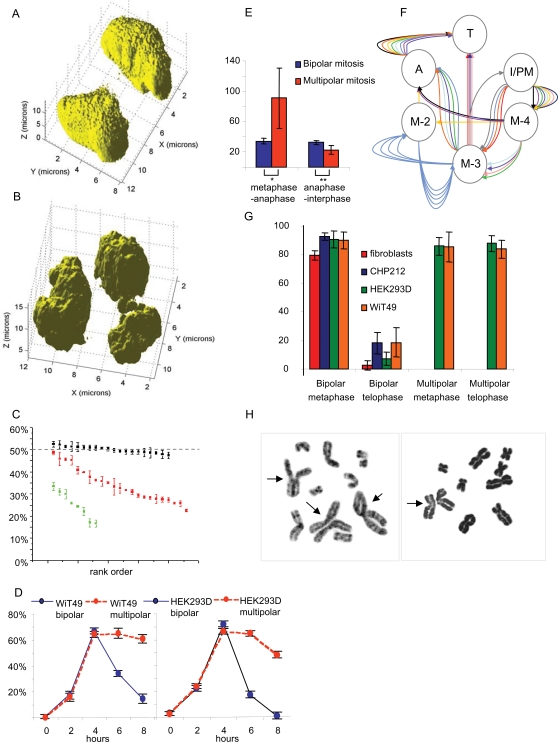
DNA distribution and timing.Reconstructed three-dimensional multiphoton cross sectioning images of a bipolar (A) and a multipolar (B) telophase cell in WiT49 show asymmetrical DNA-distribution in the latter configuration. Quantification of the relative amount of chromatin (C) in bipolar (black), tripolar (red) and tetrapolar (green) ana-telophase cells confirms a wide variation in the DNA content of multipolar daughter cells (X axis shows rank order according to DNA content). Measurement of the proportion of BrdU-positive bipolar (blue) and multipolar (red) mitotic cells at different time points after labelling (D) indicate delayed exit from mitosis for multipolar cell divisions in WiT49 and HEK293 (error bars indicate standard deviation). Time lapse imaging of H2B/GFP HEK293 cells show a prolonged metaphase-anaphase interval, and a reduced anaphase-interphase interval in multipolar compared to bipolar cell divisions (E); single and double asterisks indicate significance at the <0.05 and <0.01 levels respectively (Mann-Whitney U-test). One-per-minute time lapse imaging (F) of 12 multipolar mitoses, each corresponding to a flow of identically colored arrows, shows frequent polarity transformations (I = interphase, PM = prometaphase, M2 = bipolar metaphase, M3 = tripolar metaphase, M4 = tetrapolar metaphase, A = anaphase, T = telophase). Quantification of total intensity in arbitrary fluorescence units relative to centrosomal gamma tubulin fluorescence (G) shows a strong reduction of separase levels in telophase compared to metaphase in bipolar but not in multipolar cell divisions (error bars show standard deviation). Diplochromosomes (H, arrows) in G-banded partial metaphase spreads from WiT49.